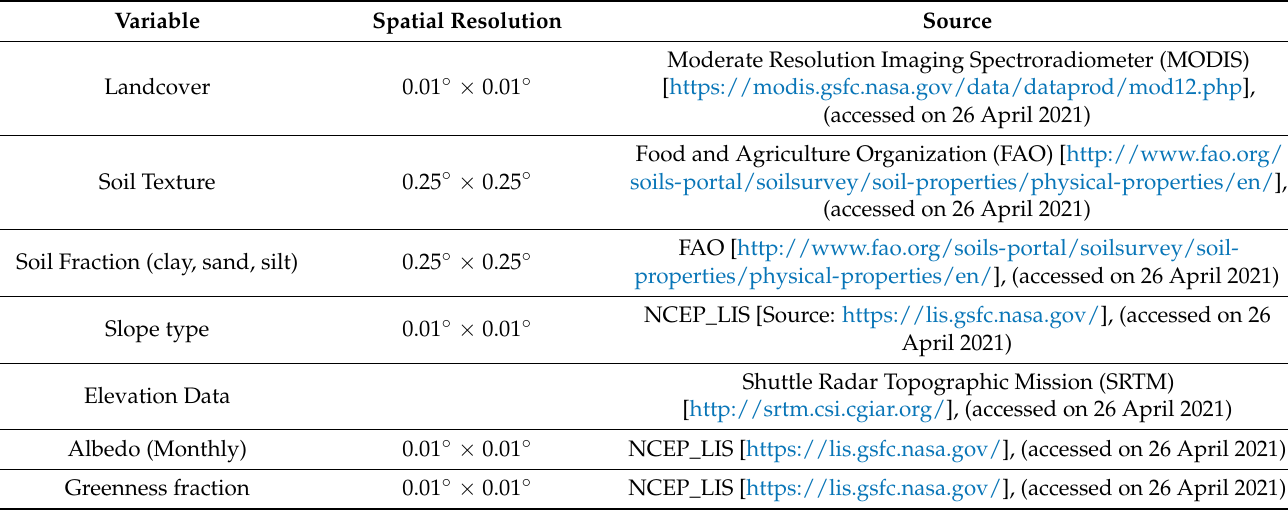
Table 2. Details of geostationary parameters used in Noah